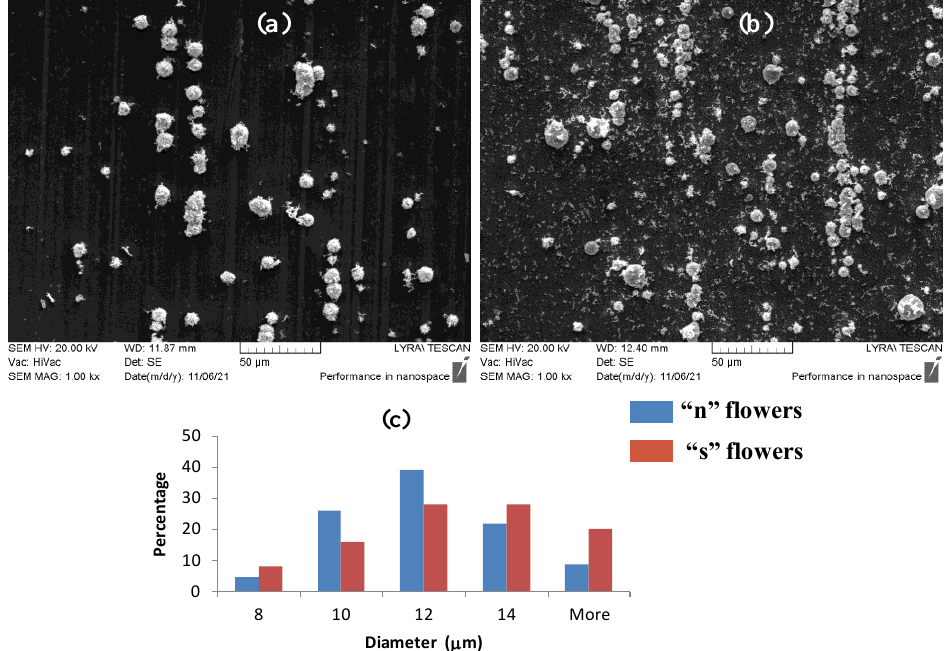
Figure 1. Scanning electron micrographs of the silver flowers on ‘n’ substrates ( a ), and ‘s’ substrates ( b ) at 1000× magnification. ( c ) Histograms with 2- μm bin range of diameter distribution of the silver flowers on both types of substrates.